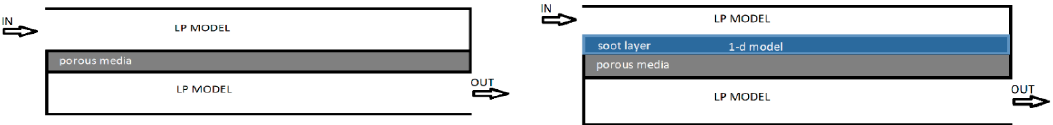
Figure 1. Scheme of diesel particulate filters (DPF) channels axial section and modelling approach.